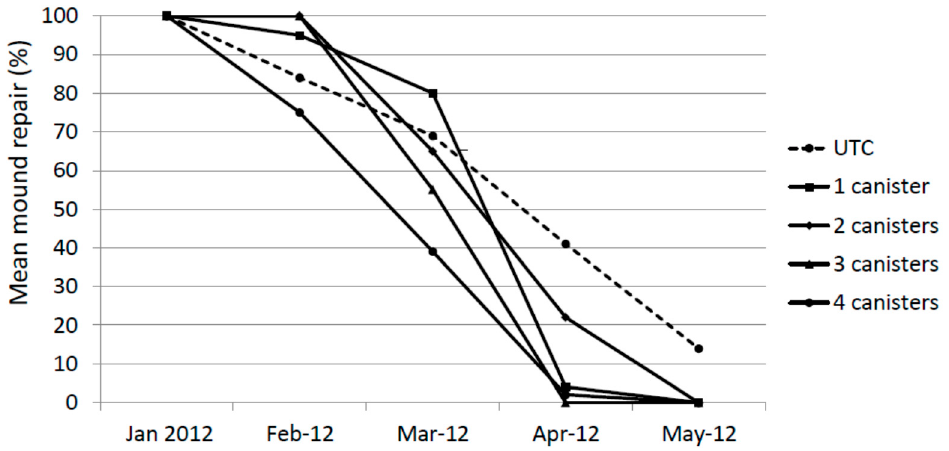
Figure 2. Mound repair (%) following experimental damage using a hand-held auger.